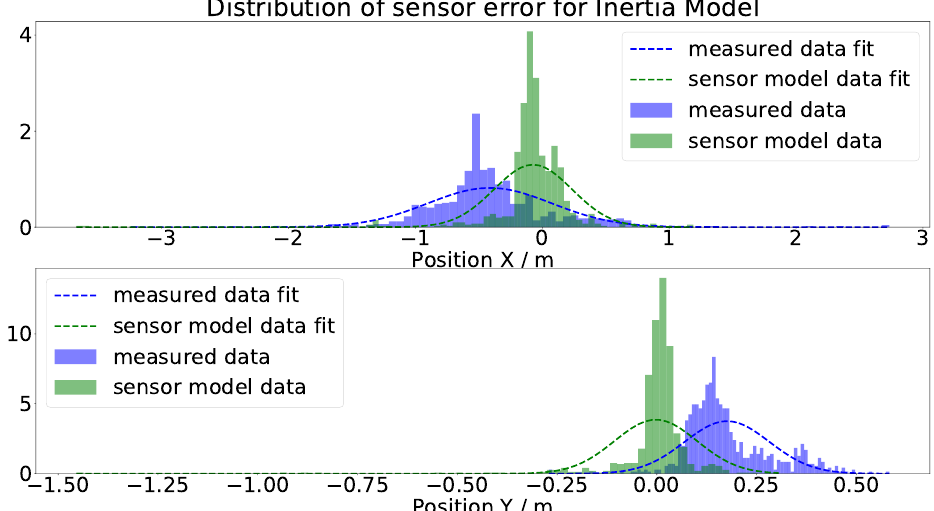
Figure 23. Histogram and Gaussian fit of the gap between the measured, respectively simulated, sensor data and the ground-truth values for the inertia